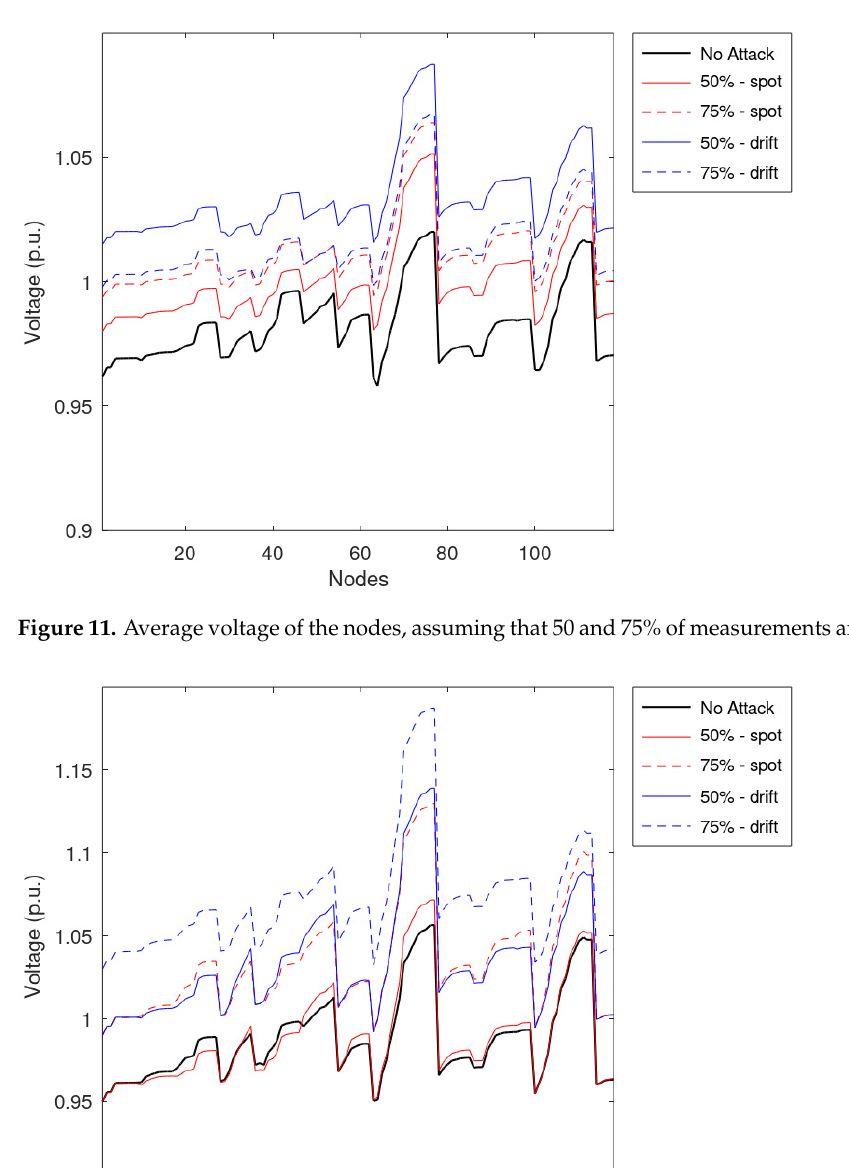
Figure 13. Maximum network voltage during the timestamps considering half of the measurements falsified.